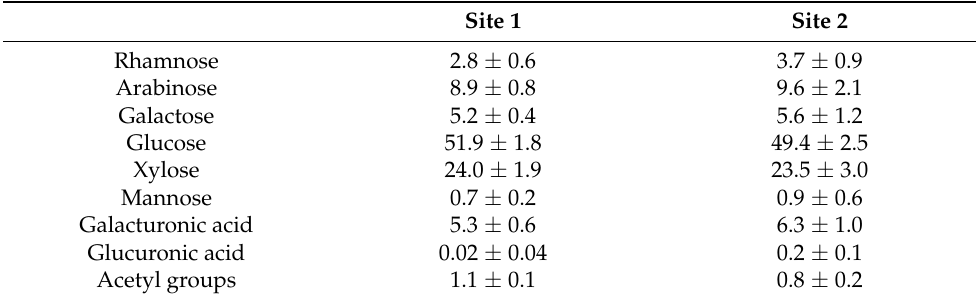
Table 3. Composition of polysaccharides (% of total monomers) determined after acid hydrolysis as neutral monosaccharides and uronic and acetic acids of Quercus rotundifolia bark sampled at b.h. from two sites (mean of five trees and standard deviation).